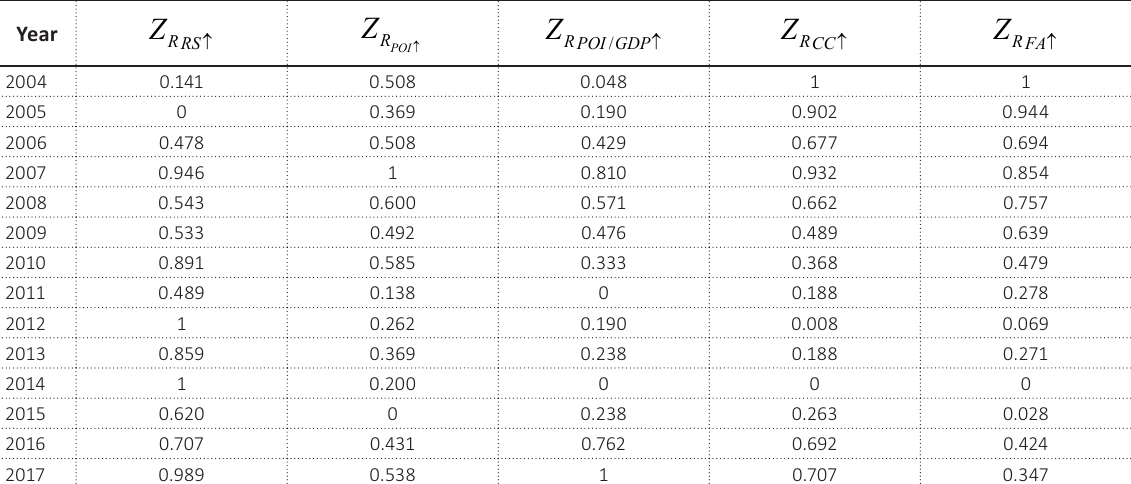
Source: Authors’ calculations.